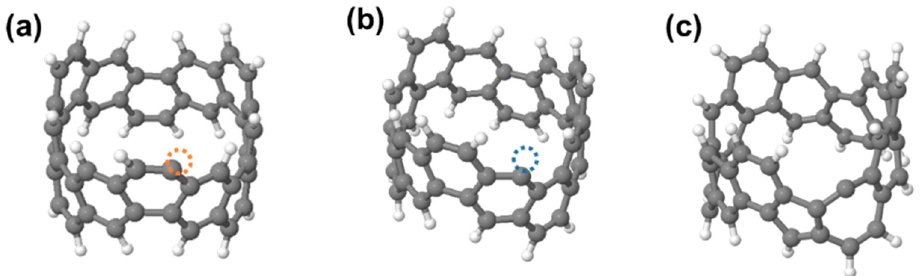
Figure 2. Molecular structures of C 48 H 23 , i.e., 1H-loss structures from an ( a ) exterior site and ( b ) interior site. Orange and blue dotted circles indicate dehydrogenated sites. ( c ) a pentagon-heptagon structure formed by Stone-Wales bond rotation of structure ( b ). Grey and white spheres indicate carbon and hydrogen atoms, respectively.